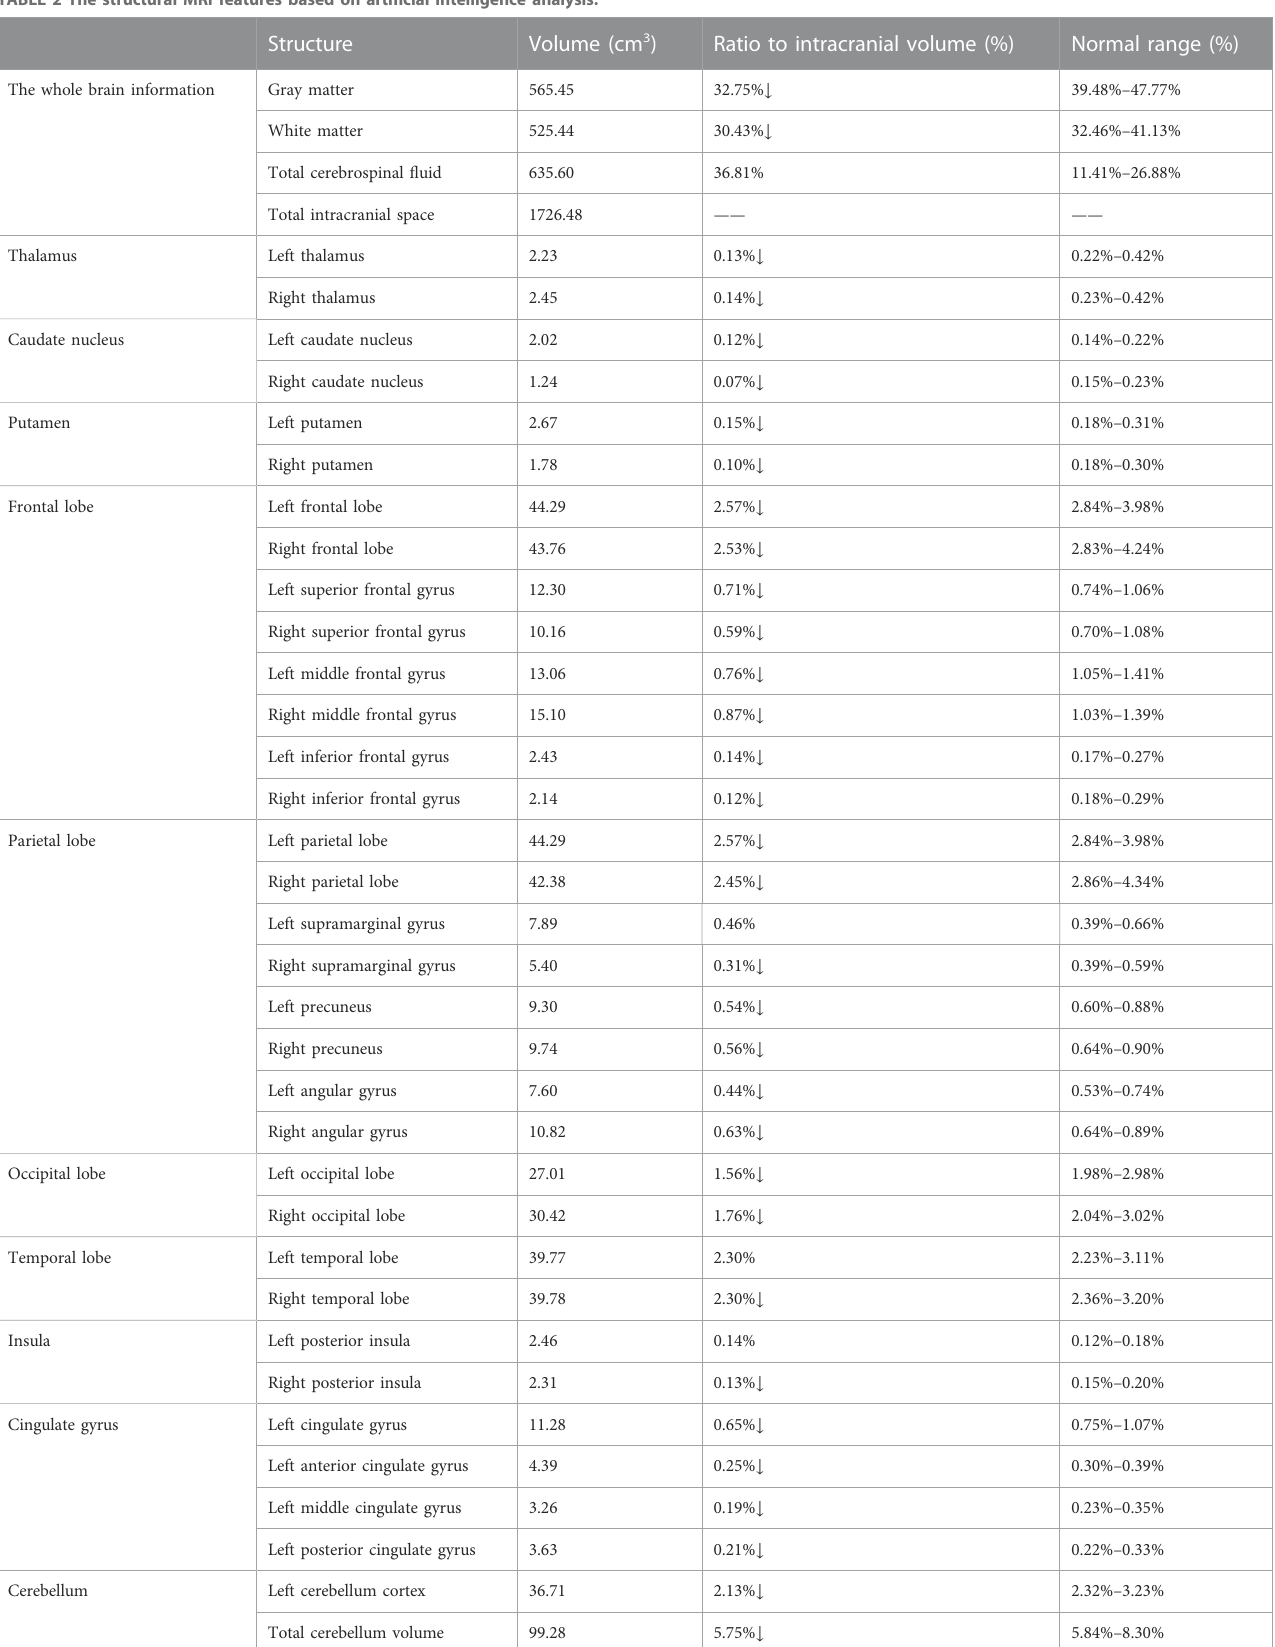
TABLE 2 The structural MRI features based on arti fi cial intelligence